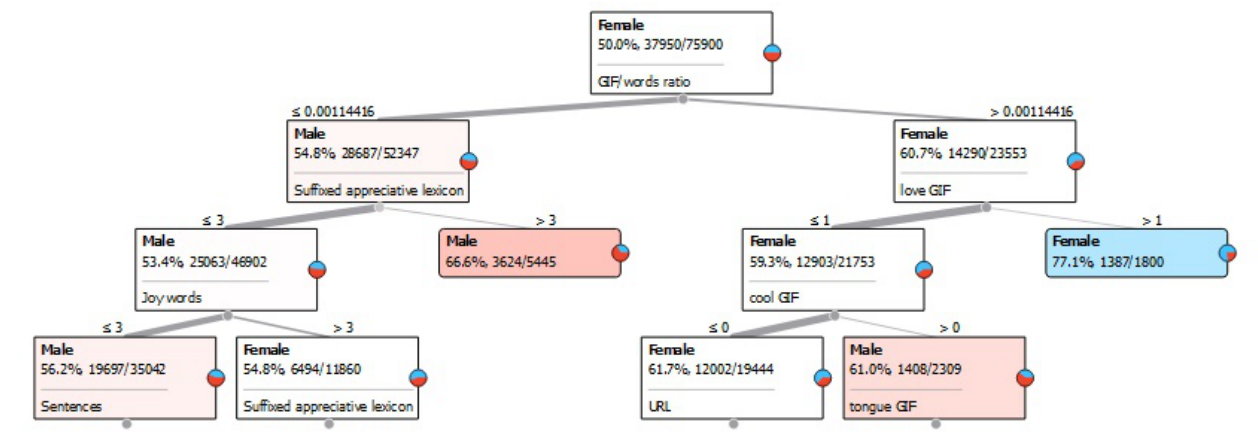
Figure 1. The first four levels of the DLS